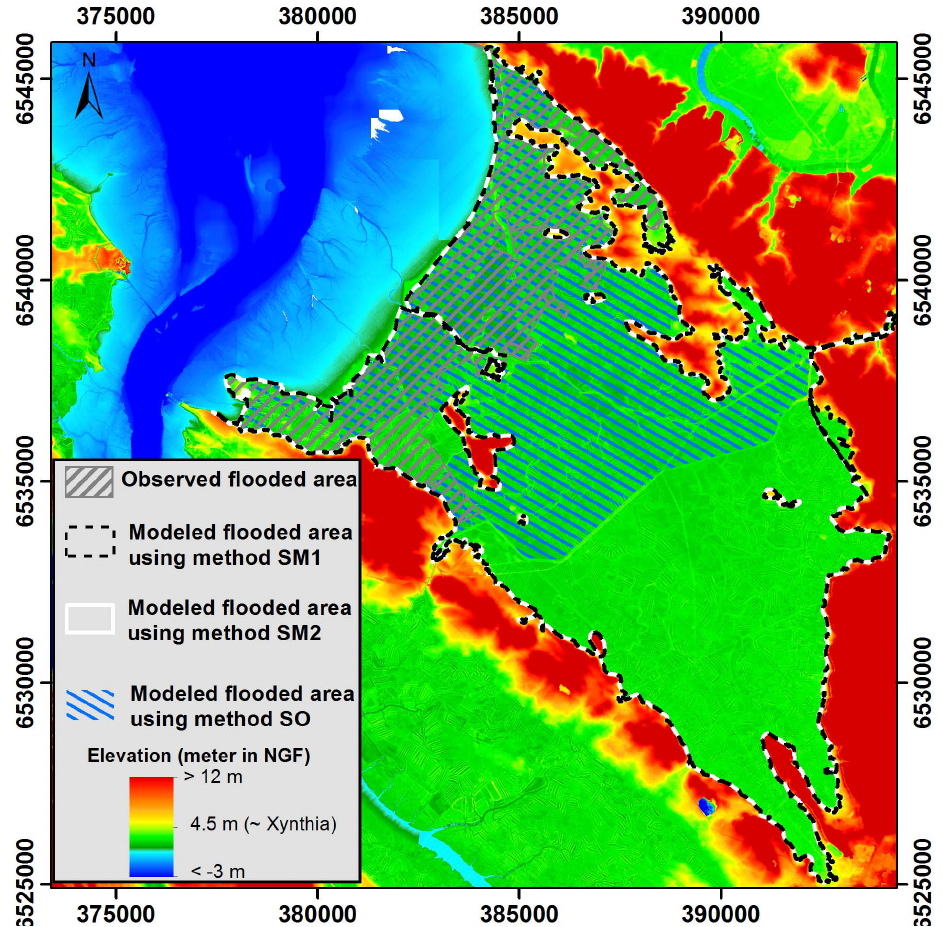
Fig. 8. Digital Terrain Model (DTM) of the Brouage Marsh (no. 24) showing the observed flooded area (hatched grey lines), the modeled flooded area using method SM1 (black dotted line), the modeled flooded area using method SM2 (white line) and the modeled flooded area using method SO (hatched blue